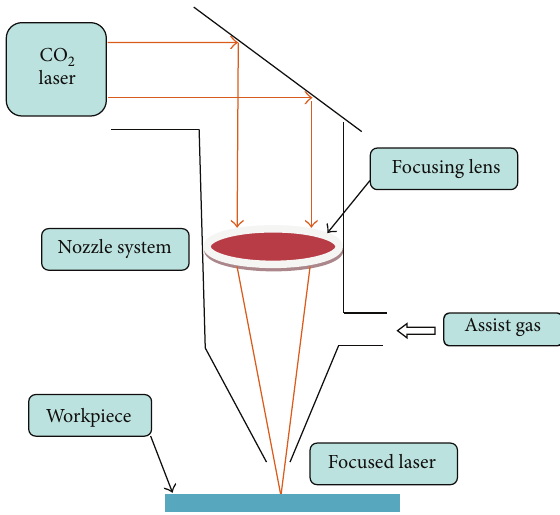
Figure 2: Experimental setup for laser cutting process.